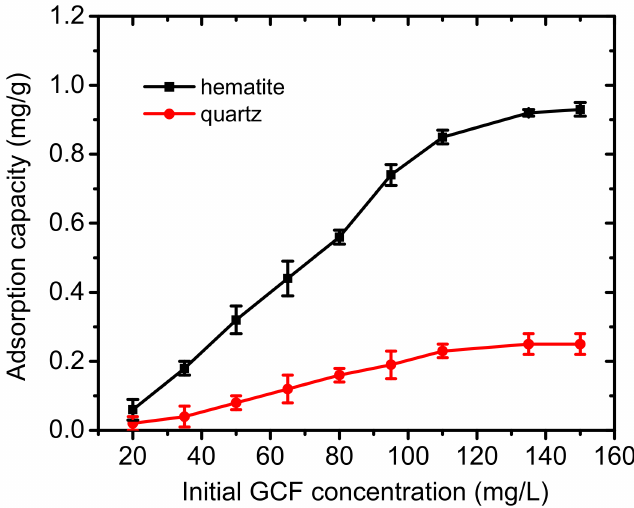
Figure 11. Determination of the adsorption amount of graft copolymer on mineral